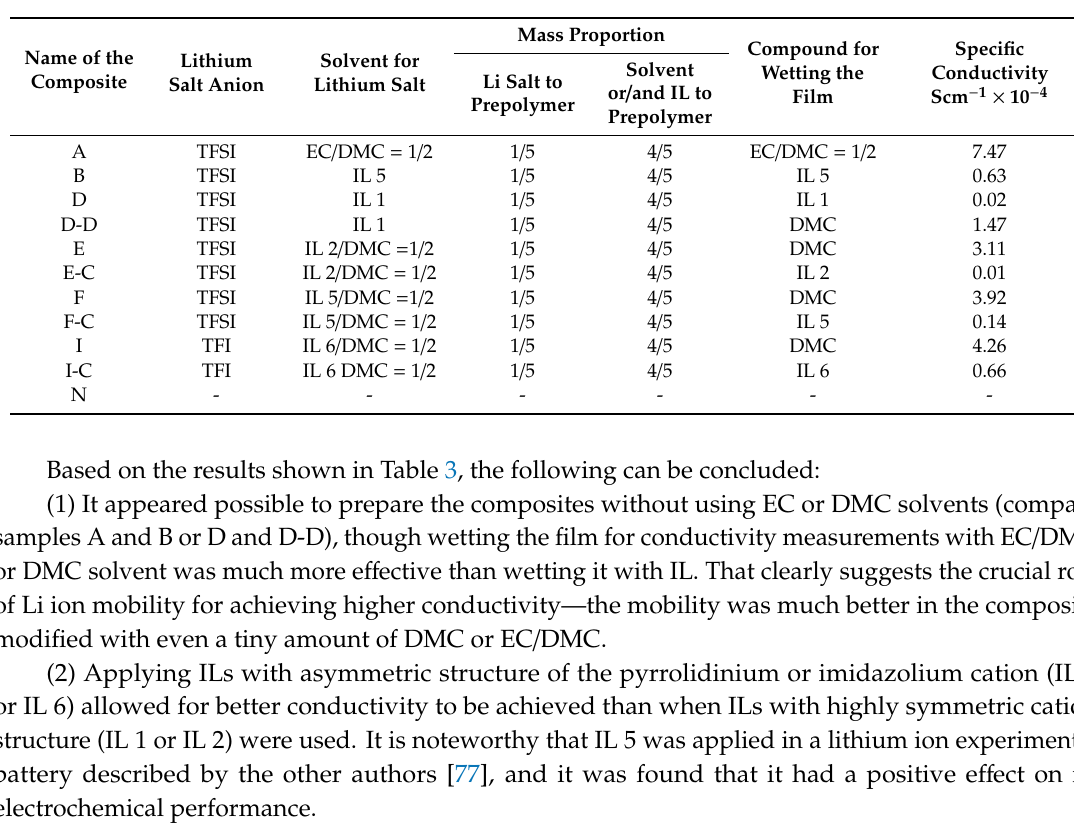
Table 3. Compositions of the PSUR-based UV-cured composites containing non-reactive ILs obtained in the study and the results of specific conductivity determinations. Composite prepared without IL (A) was included for comparison. Composite N without any solvent and lithium salt was also prepared for Tg determinations only.